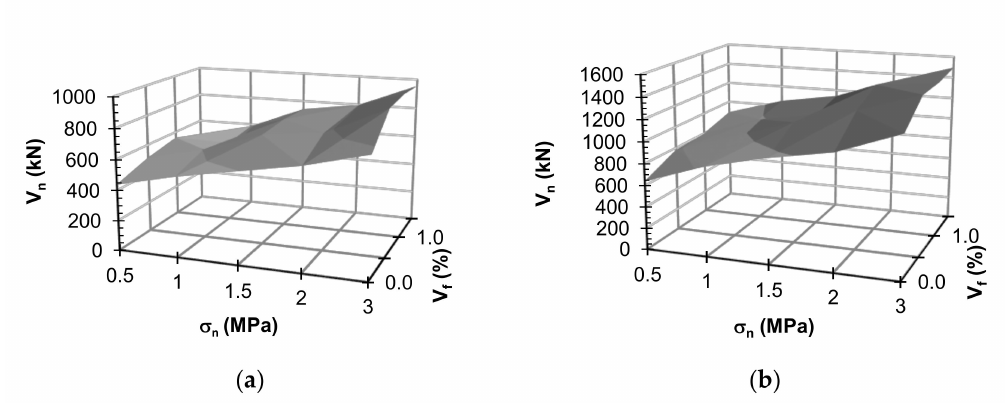
Figure 13. Nominal shear capacity in terms of prestress and fiber volume fraction: ( a ) N k = 3, ( b ) N k =